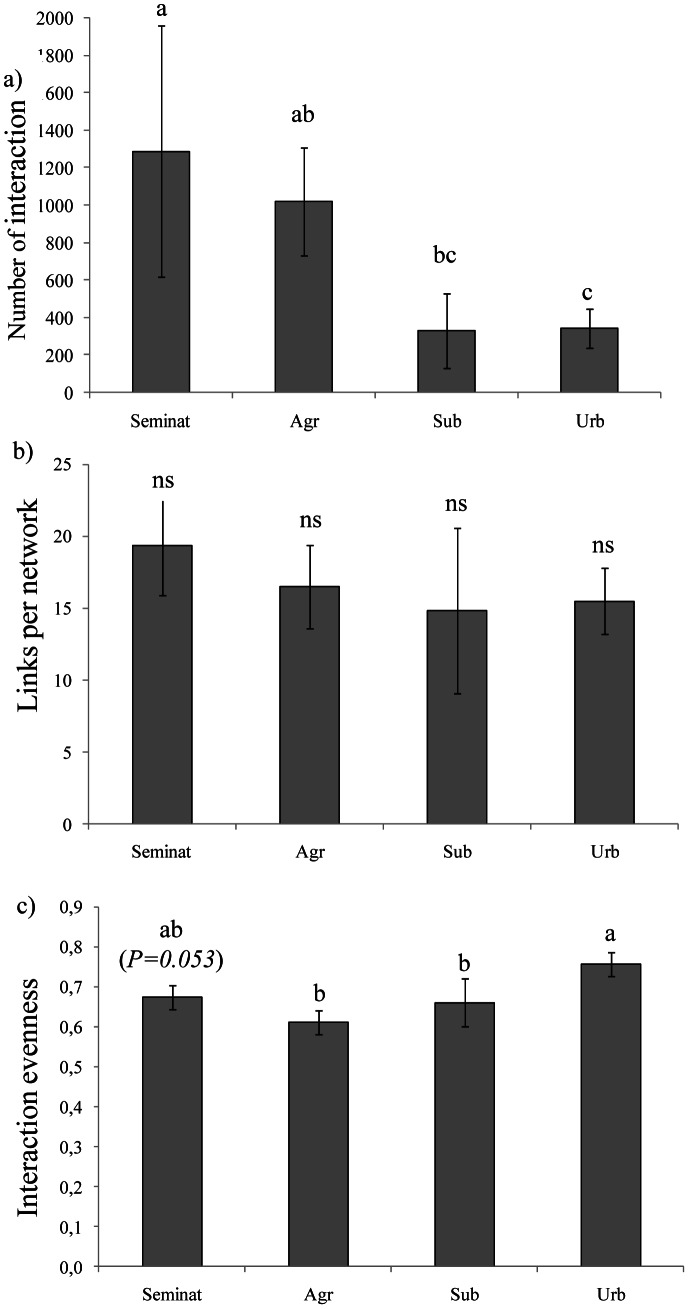
Network level indices pollinators according to the landscape context.a) Mean number of interactions between plants and flower-visitors b) Mean number of links per network. c) Mean interaction evenness. Lines above bars denote 95% confidence interval. Bars that do not share the same letter show significant differences (P<0.05). NS: no significant differences (P>0.05). Seminat: Semi-natural; Agr: Agricultural; Sub: Suburban; Urb: Urban.